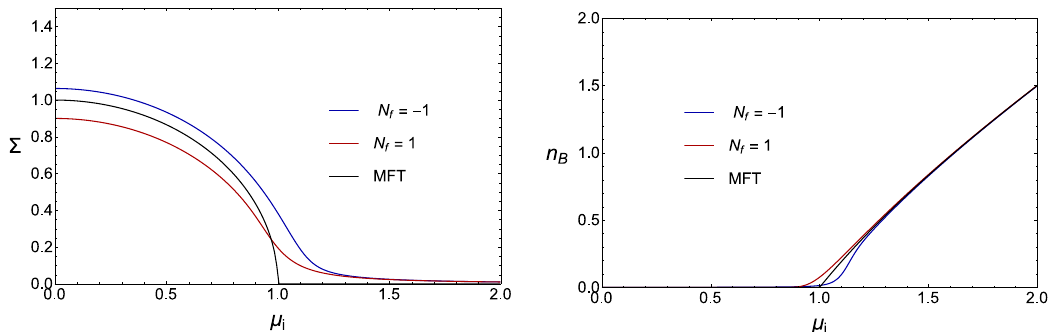
Figure 2 . The chiral condensate (left) and the baryon density (right) as a function of the imaginary chemical potential. We show the result for the one-(cid:13)avor bosonic partition function (blue), the one (cid:13)avor fermionic partition function (red) and the mean (cid:12)eld result (black).